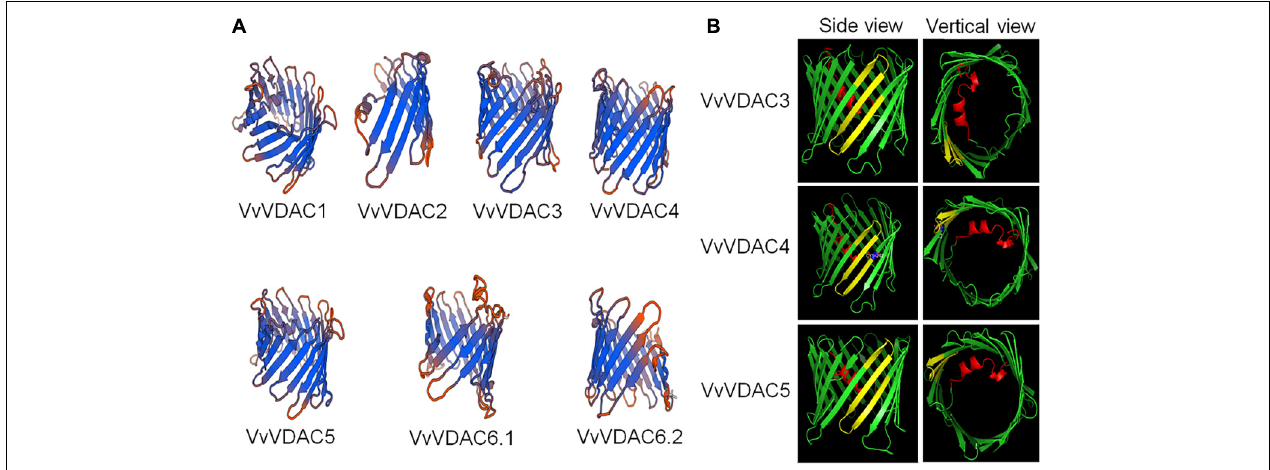
FIGURE 1 | Three-dimensional structure prediction and MPS domain localization of VvVDACS . (A) Three-dimensional structure of VvVDACS is represented by a ribbon diagram. (B) Prediction of MPS motif structures for VvVDAC3 , VvVDAC4 , and VvVDAC5 (side and vertical views). VvVDAC is a β -barrel (in green) formed by anti-parallel β -strands; the strands are connected by loops (in green). The N-terminal domain (in red) is arranged in an α -helix and is located inside the pore’s lumen. The cysteine residue at amino acid 242 of VvVDAC4 is marked in